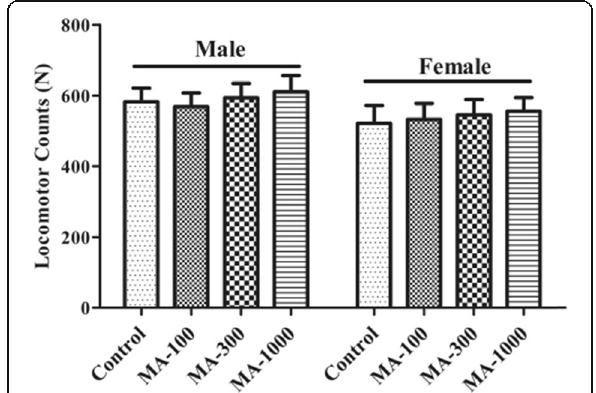
Fig. 2 Effect of MA (100, 300 and 1000 mg/kg/b.w.) on locomotor counts in actophotometer test. Values are mean ± SD, n = 6 animals in each group. P value ( P < 0.05) was considered as statistically significant. Data was analyzed via one-way ANOVA followed by Newman-Keuls Multiple Comparison Test